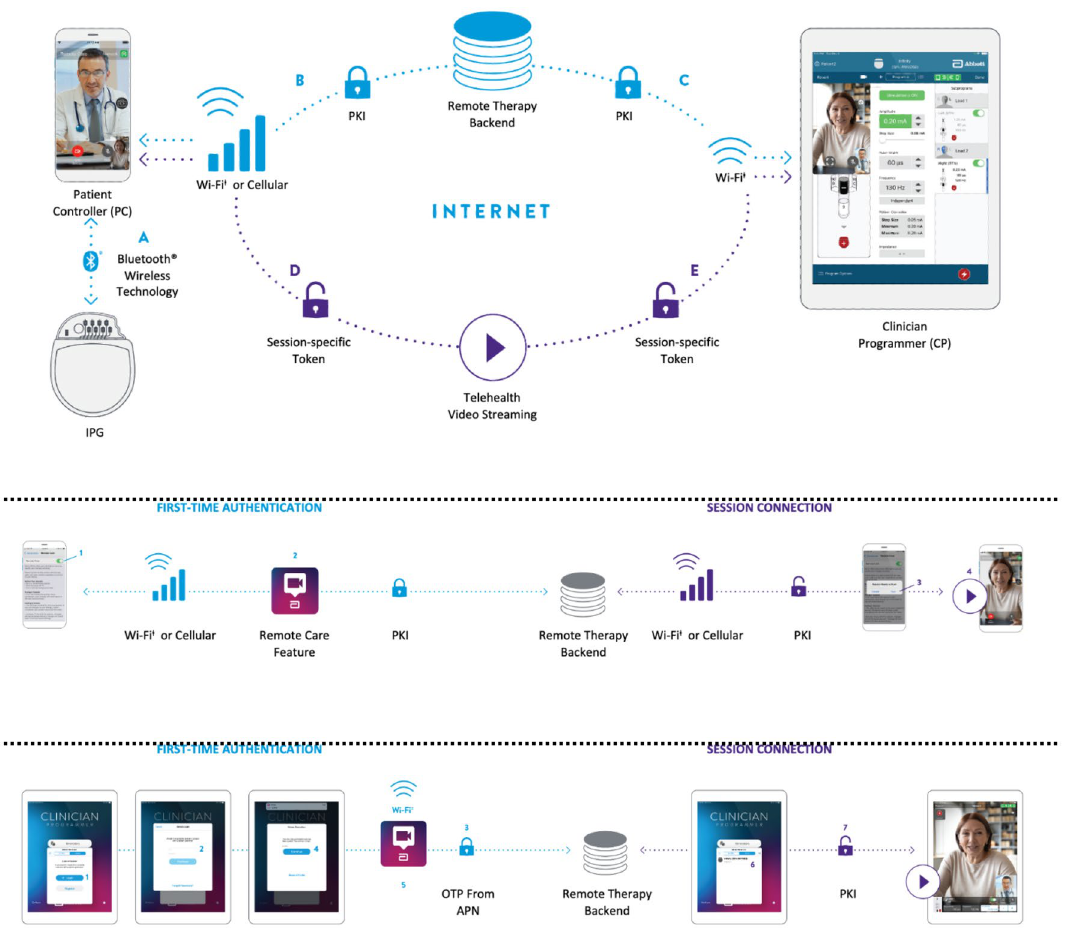
Figure 4. Remote care platform architecture and communication pathways. Top: There are two communication pathways integrated into the remote care platform: device programming pathway (blue) and video communication pathway (purple). ( A ) Two-way Bluetooth wireless technology-enabled communication between IPG and PC. ( B ) Two-way Wi-Fi‡ or cellular communication of data over the patient’s network between the PC and Remote Therapy Backend; data are protected through PKI. ( C ) Two-way Wi-Fi‡ communication of data over the clinician’s network between the CP and Remote Therapy Backend; data are protected through PKI; CP does not communicate directly with the patient’s IPG during a remote session. ( D ) Two-way Wi-Fi‡ or cellular communication of video streaming data over the patient’s network between the PC and video streaming service; session-specific token issued for each video session. ( E ) Two-way Wi-Fi‡ communication of video streaming data over the clinician’s network between the CP and video streaming service; session-specific token issued for each video session. Middle : Connection from the patient perspective is divided into first-time authentication (Blue; step 1: Remote Care Feature enablement and step 2: Remote Therapy Backend enablement) and session connection (Purple; step 3: PC app availability is advertised for a Virtual Clinic session and step 4: video data session is established). Bottom: Connection from the clinician perspective is divided into first-time authentication (Blue; steps 1–5) and session connection (Purple: steps 6–7): step (1) User registers the CP app for the Virtual Clinic; step (2) User creates username and password; step